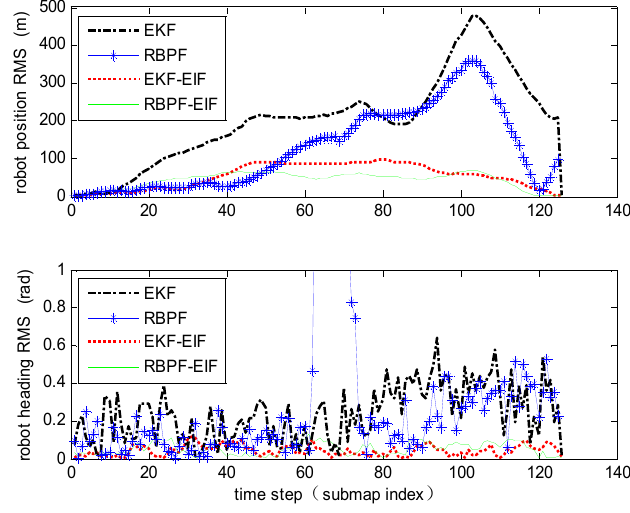
Figure 7. RMS errors of robot pose and feature by using the four algorithms.